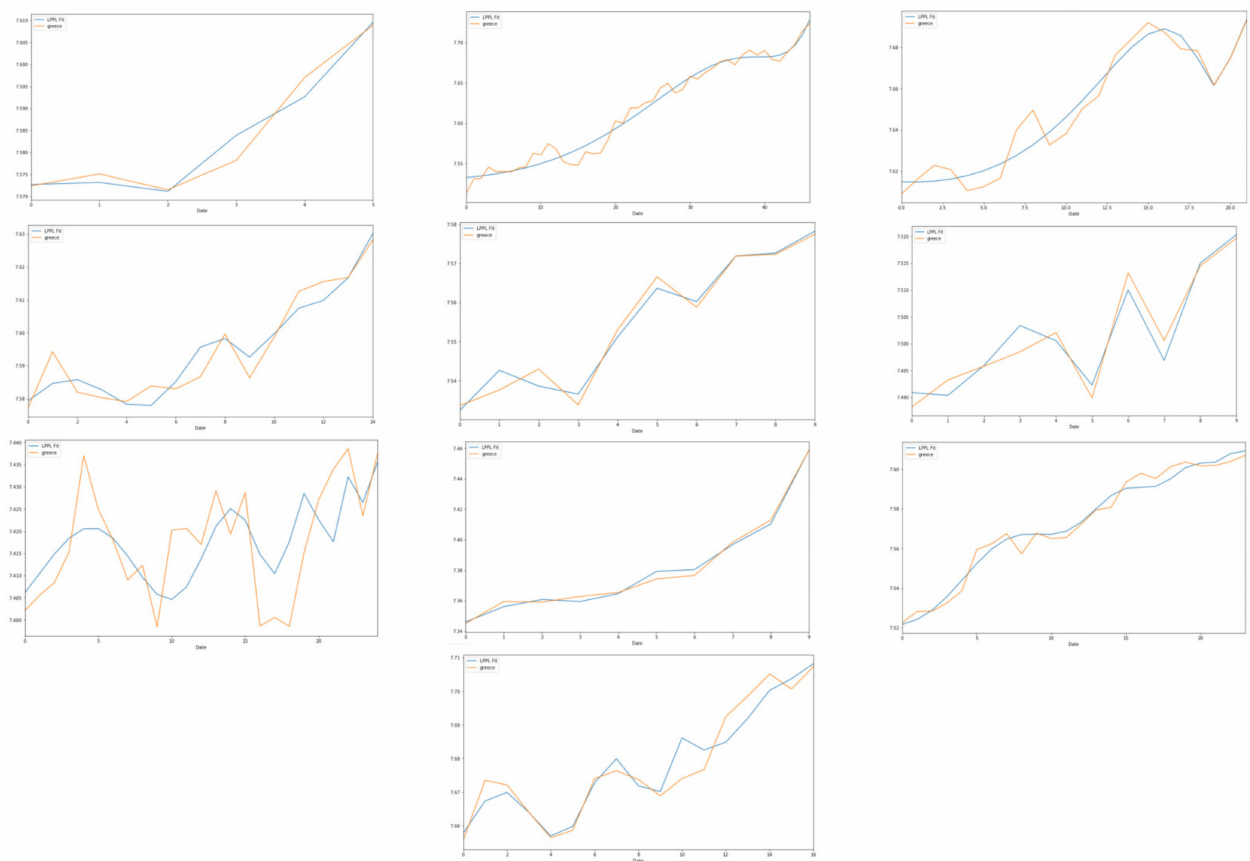
Figure A3. LPPL Signatures in the Greek Stock Exchange (FTSE/ATHEX) 19 January 2015 to 17 February 2020. Log-periodic power law signatures in the Greek Stock